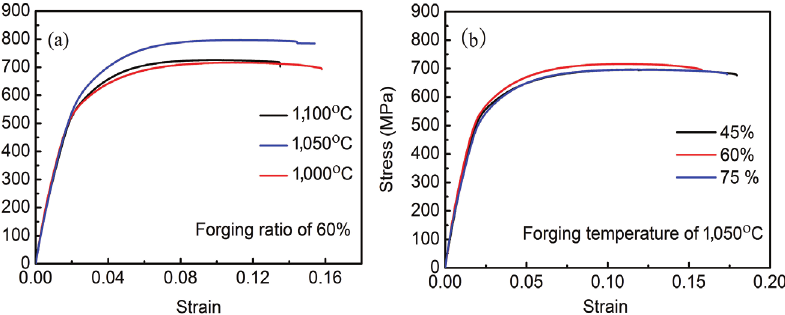
Figure 7: The stress – strain curve of forged Ti-7Cu alloy (a) with different forging temperatures, (b) with different forging